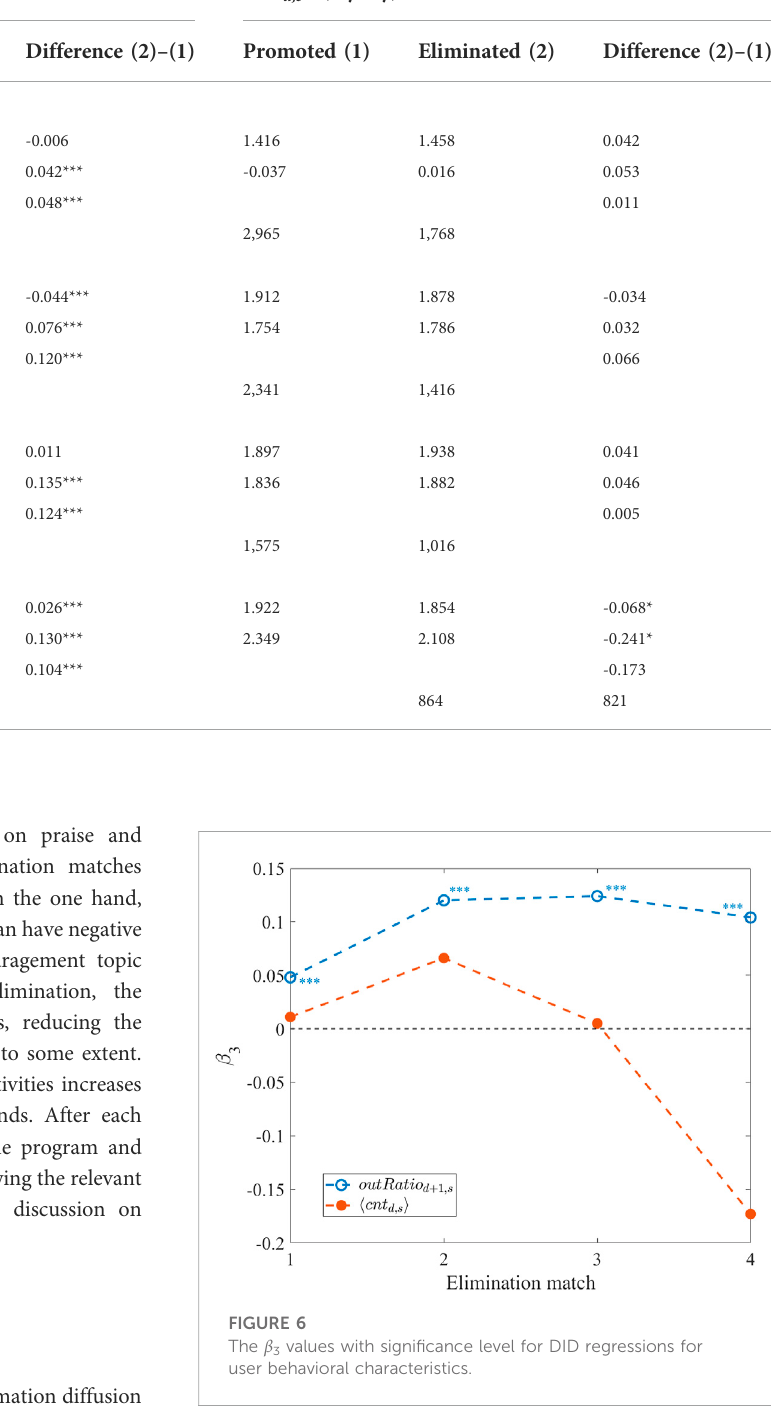
TABLE 4 DID regression results for user behavioral characteristics for four elimination matches. outRatio d+1,s (popularity)